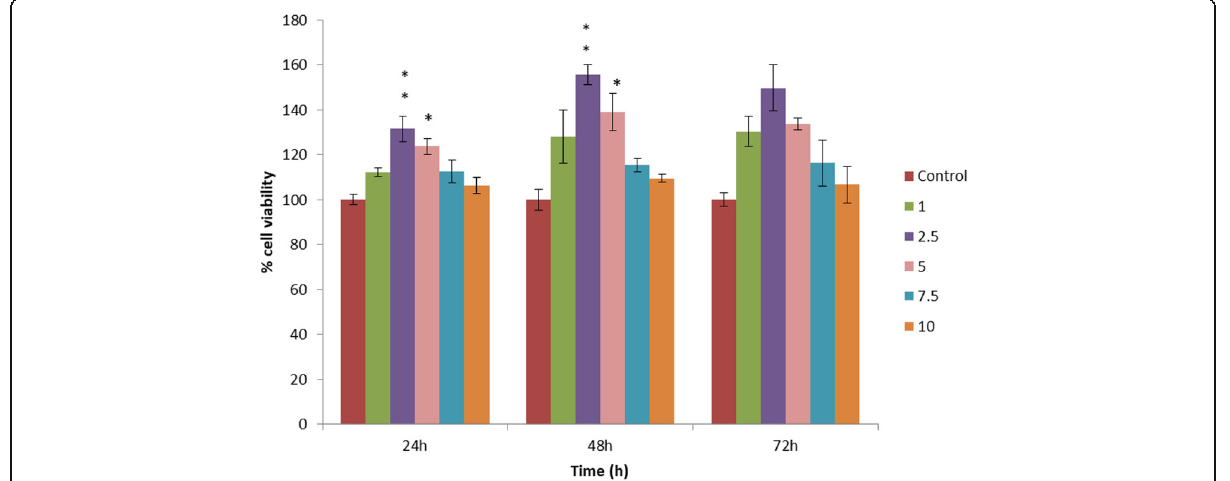
Fig. 10 Effect of AiP1 on viability of HEK293 cells in vitro: An increase in cell viability was observed post treatment with AiP1 compared to untreated cells (control). Doses up to 5 μ g/ml AiP1 showed maximum increase in cell viability